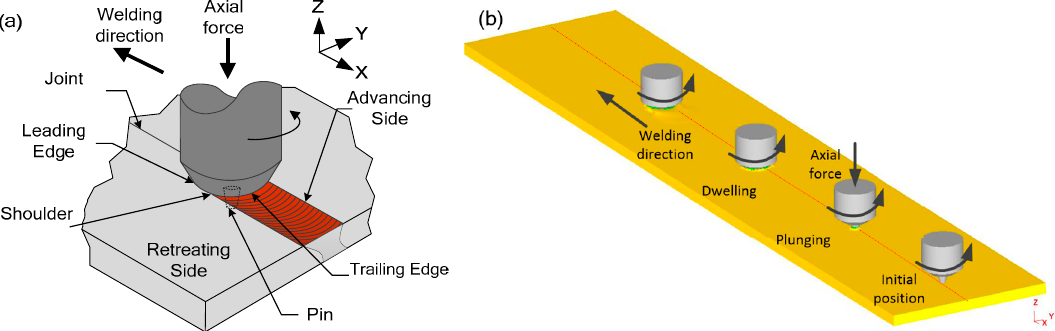
Figure 1. Schematic diagram of welding process. ( a ) Schematic diagram of friction stir welding area; ( b ) different stages of welding process.